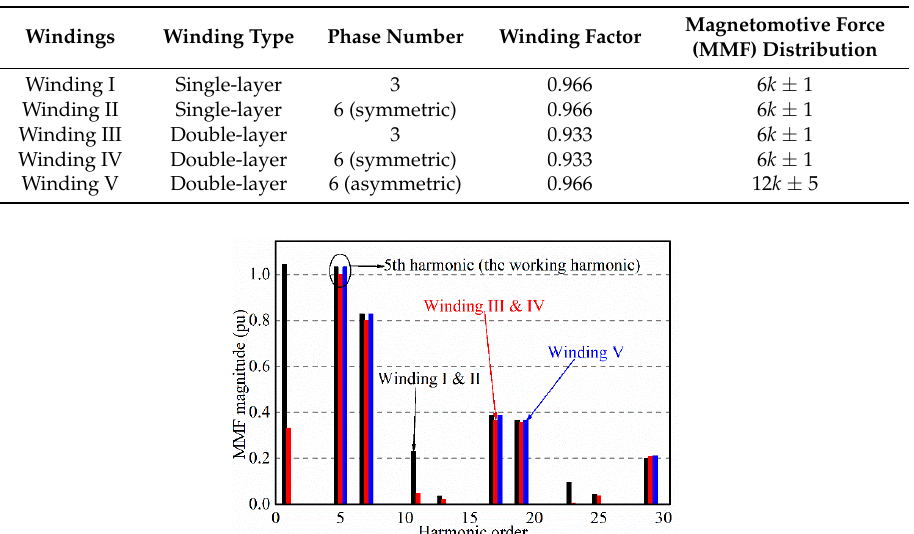
Figure 2. The simulation results of MMF distributions of the different winding layouts for the 12- slot/10-pole configuration.